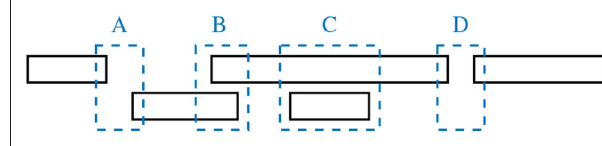
FIGURE 1 | Turn-taking categories: between-speaker silence, BSS (A) ; between-speaker overlap, BSO (B) ; within-speaker overlap, WSO (C) ; and within-speaker silence, WSS (D) . The top and bottom boxes represent individual speakers’